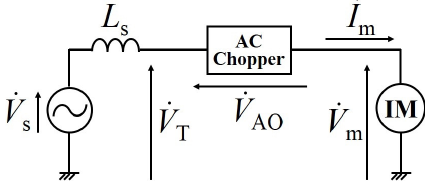
Figure 2. Single-phase equivalent circuit of Figure 1.